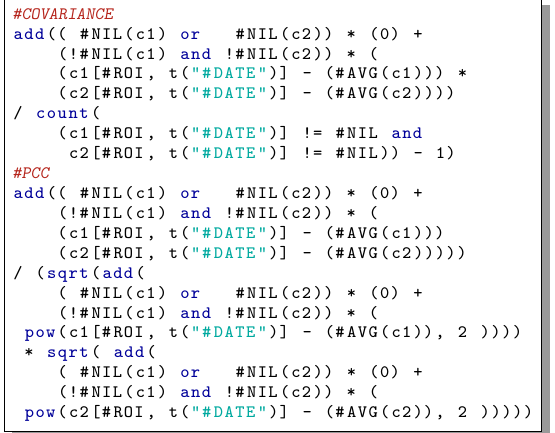
Listing 4: Bivariate statistics: sample covariance and Pearsons’ r linear Correlation Coefficient (see Eq.